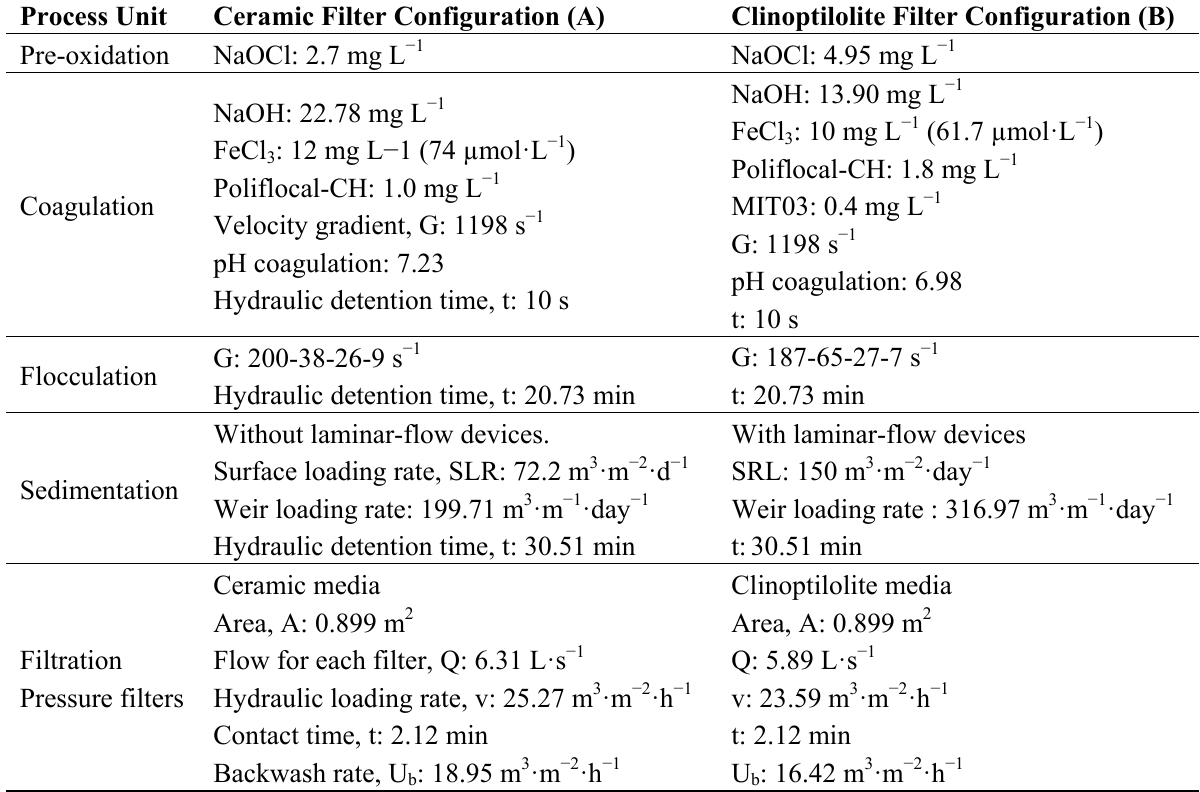
Table 4. Operating conditions of the two